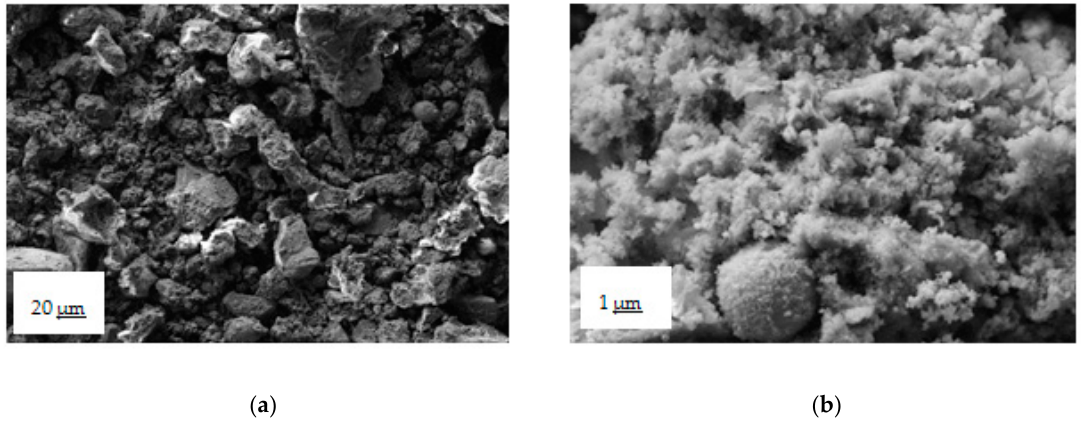
Figure 10. ( a ) SEM image of the solid precipitates in the authentic solution experiment, where the bar indicates 20 μ m length; ( b ) SEM image of the solid precipitates in the authentic solution experiment, where the bar indicates 1 μ m length.